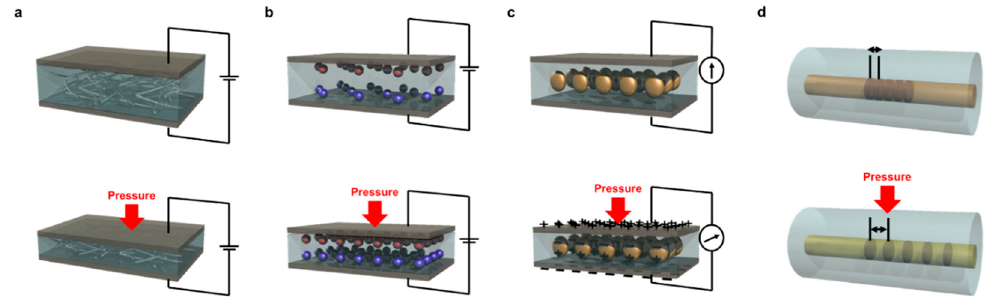
Figure 2. Schematic illustrations of transduction mechanisms of tactile sensors: ( a ) piezoresistivity; ( b ) ( b ) capacitance; ( c ) piezoelectricity; ( d ) capacitance; ( c ) piezoelectricity; ( d ) optics.